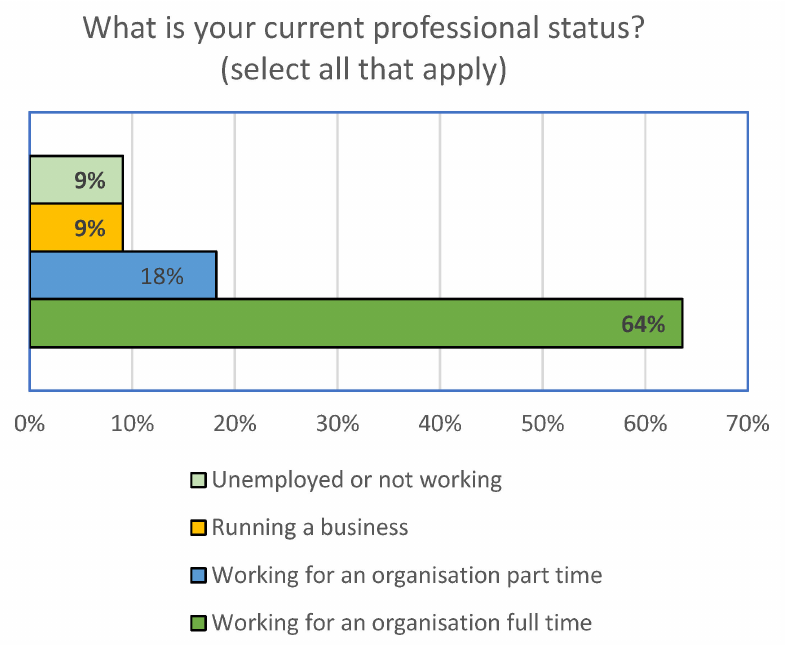
Figure 7. Professional status of respondents.